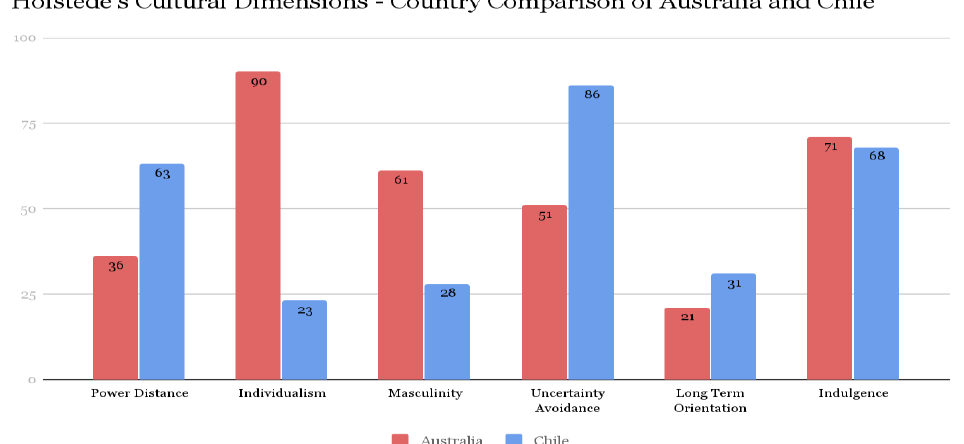
Figure 2: Hofstede’s Cultural Dimensions – Country comparison between Australia and